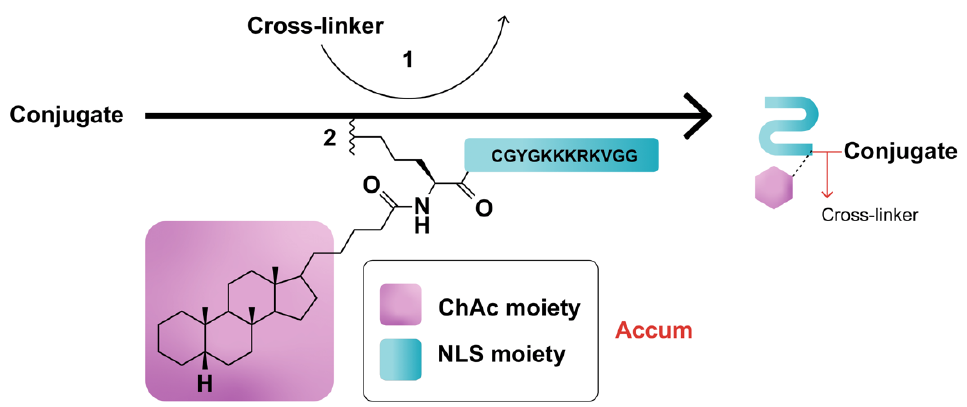
Figure 1. Schematic representation of Accum-modification of protein conjugates. In step (1), the protein reacts with a cross-linker, yielding a maleimide-activated conjugate. In step (2), the sulfhydryl group of the N-terminus cysteine cap of the NLS moiety of Accum reacts with the maleimide-activated conjugate, yielding an Accum-conjugate.